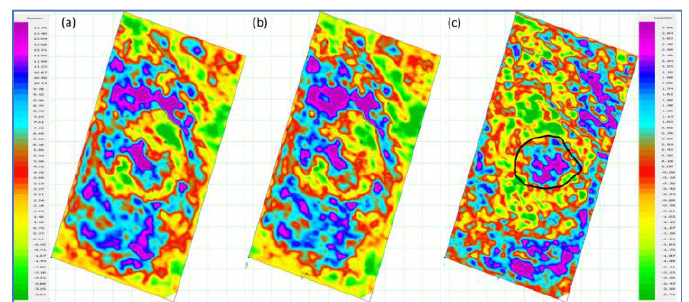
Figure 5. Horizon slice on a window between the upper and lower parts of the reservoir of the final migrated seismic stack volume: ( a ) baseline seismic volume; ( b ) monitor seismic volume, and ( c ) the seismic difference between baseline and monitor surveys. Block polygon that includes the high amplitude difference at the crest of the reservoir. Diagnostic 4D QC attributes were extracted at each stage of 4D seismic co-processing, e.g., NRMS were examined to ensure that vintages become increasingly comparable. De-